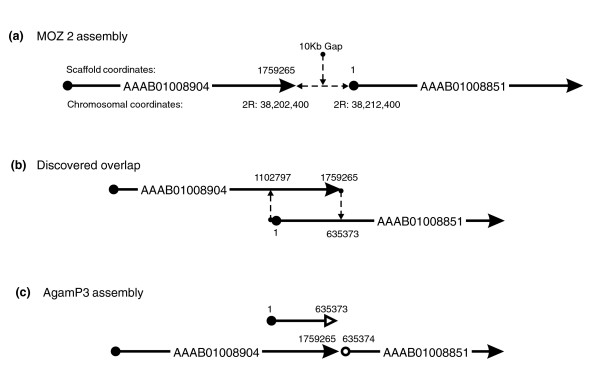
Example of joining scaffolds where adjacent ends are alternative assemblies of the same region. (a) Using physical mapping techniques, scaffolds AAAB01008904 and AAAB0108851 are placed adjacent to one another on chromosome arm 2R. In the previous genome assembly, MOZ2, the scaffolds were placed with an arbitrary 10 kbp of gap between them. (b) After alignment of scaffolds using Exonerate and Dotter, it was clear that there was about 64 kbp of sequence overlap between the 3' end of AAAB01008904 and the 5' end of AAAB0108851. Based on BAC coverage of each scaffold and gaps in each of the scaffold sequences, we chose to keep the overlapping region from AAAB01008904 (base-pairs 1102797 to 1759265) and use it for the new chromosome assembly. (c) The corresponding overlapping region from AAAB0108851 (base-pairs 1 to 635373) was deemed to be an alternative assembly segment, with the rest of the scaffold kept as part of the chromosome assembly. The regions retained as parts of chromosome arm 2R were placed adjacent to each other with no inter- scaffold gap.